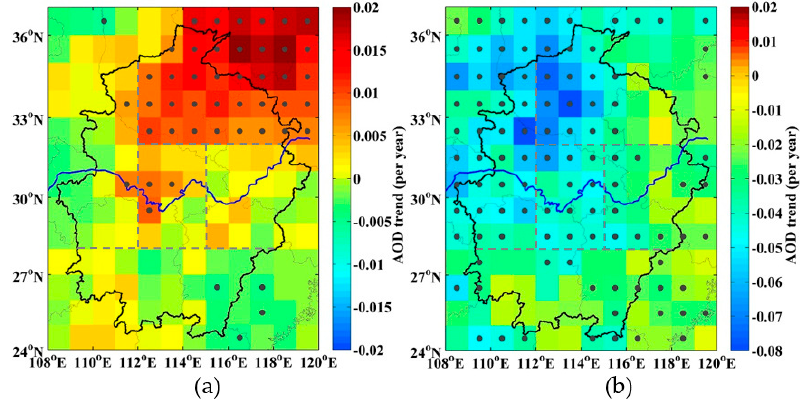
Figure 5. Deseasonalized AOD trends over central China: ( a ) from 2001 to 2015, and ( b ) from 2011 to 2015. Regions with significant trends ( p value < 0.05) are indicated by dots.